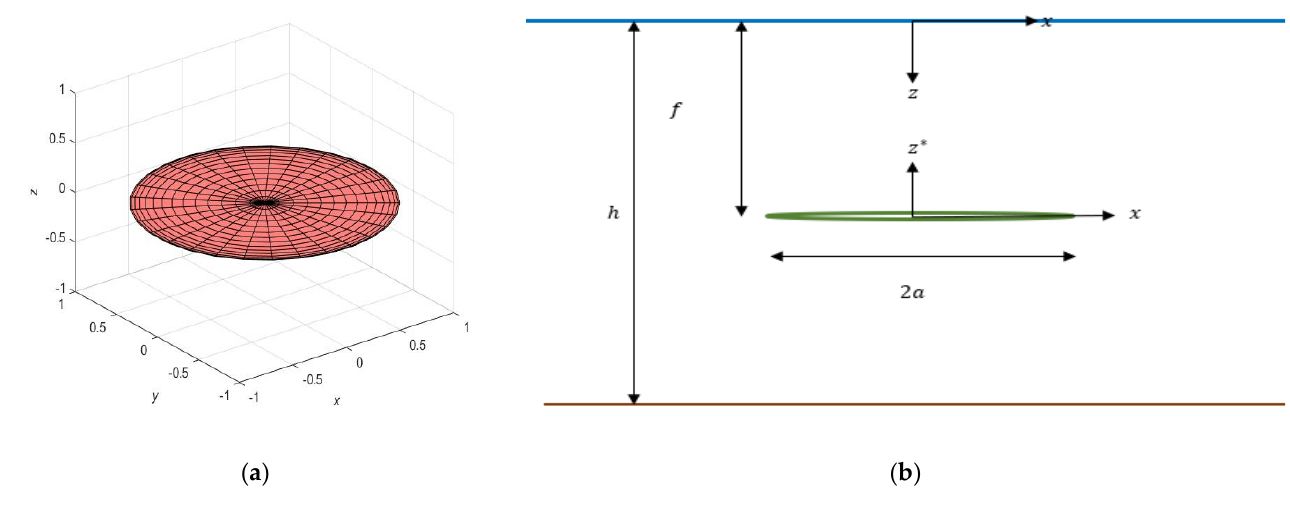
14 of 16 Figure 11. Normalized damping coefficient for a/b= 1.1, f = 9a and h = 10a: surge and heave mo- tion. 5. The Special Case of a Disc